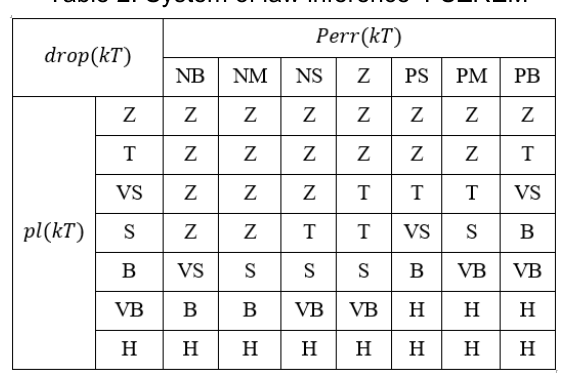
Table 2. System of law inference FUZREM